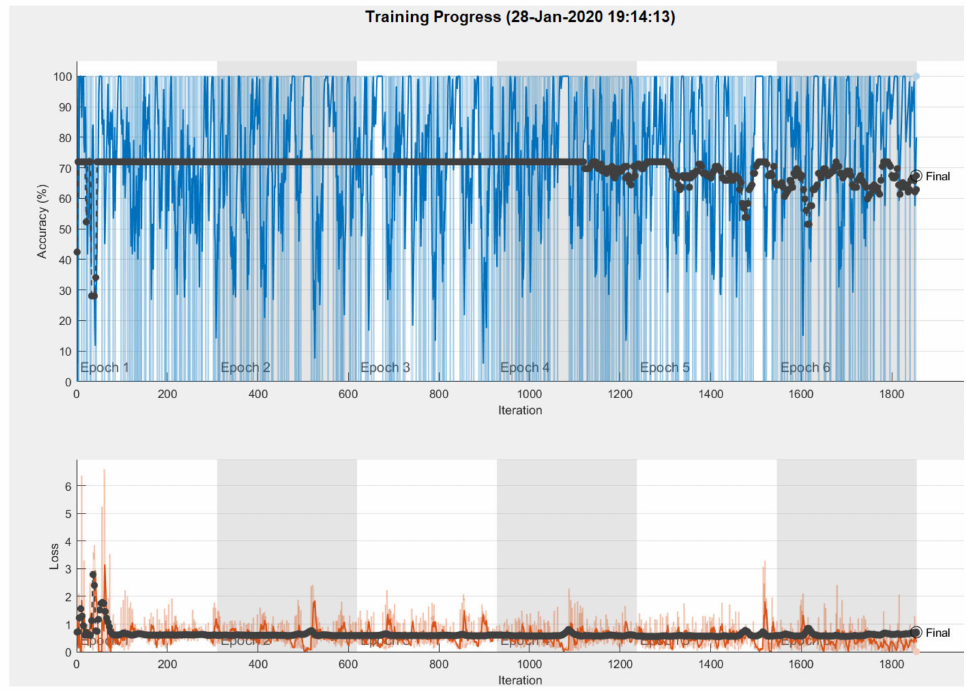
Figure 26. Training progress NasNet-Large